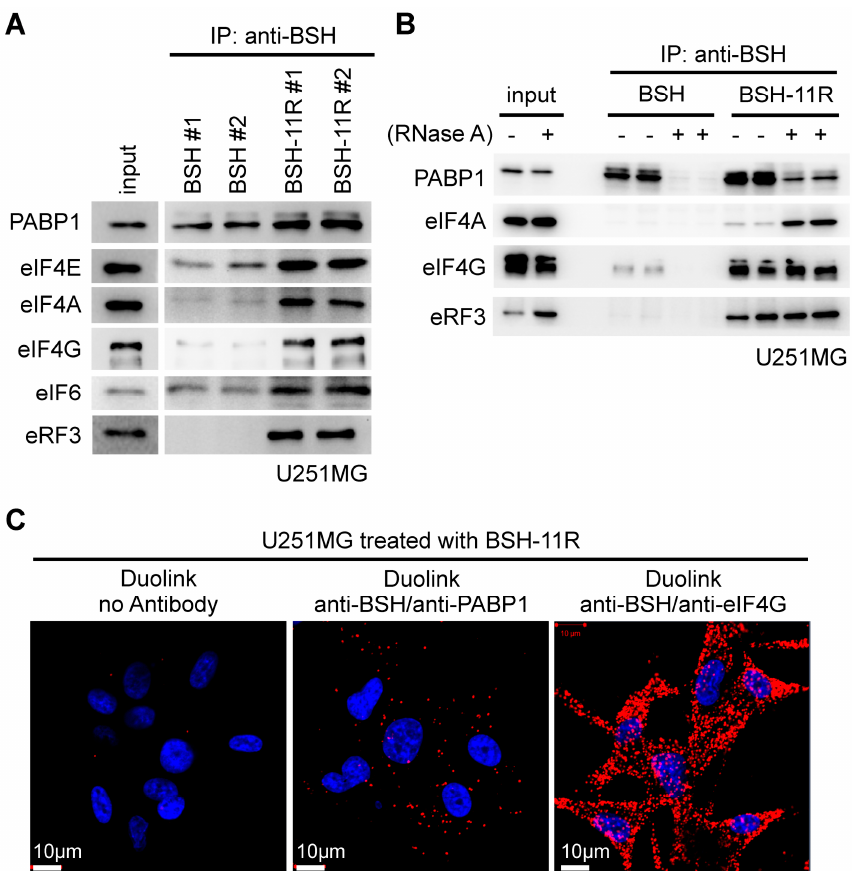
Figure 6. BSH-11R bound to the translation-related proteins. ( A ) BSH interacted with poly(A)-biding protein 1 (PABP1) and polyR allowed BSH to bind with the translation initiation factors and termination factor. ( B ) The interaction between PABP1 and BSH was RNA-dependent. The BSH-polyR interactions of eIF4A, eIF4G, and eRF3 appear dependent on the polyR part. ( C ) A Duolink assay confirmed the in situ interactions between BSH-11R and PABP1 or eIF4G in U251MG cells.